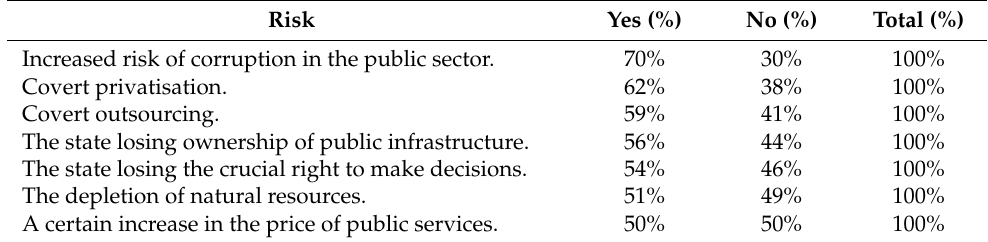
Table 1. Answers to the question: “Which of these statements describe best the risks of public-private partnerships for the public sector and the community?”. Risk Yes (%) No (%) Total